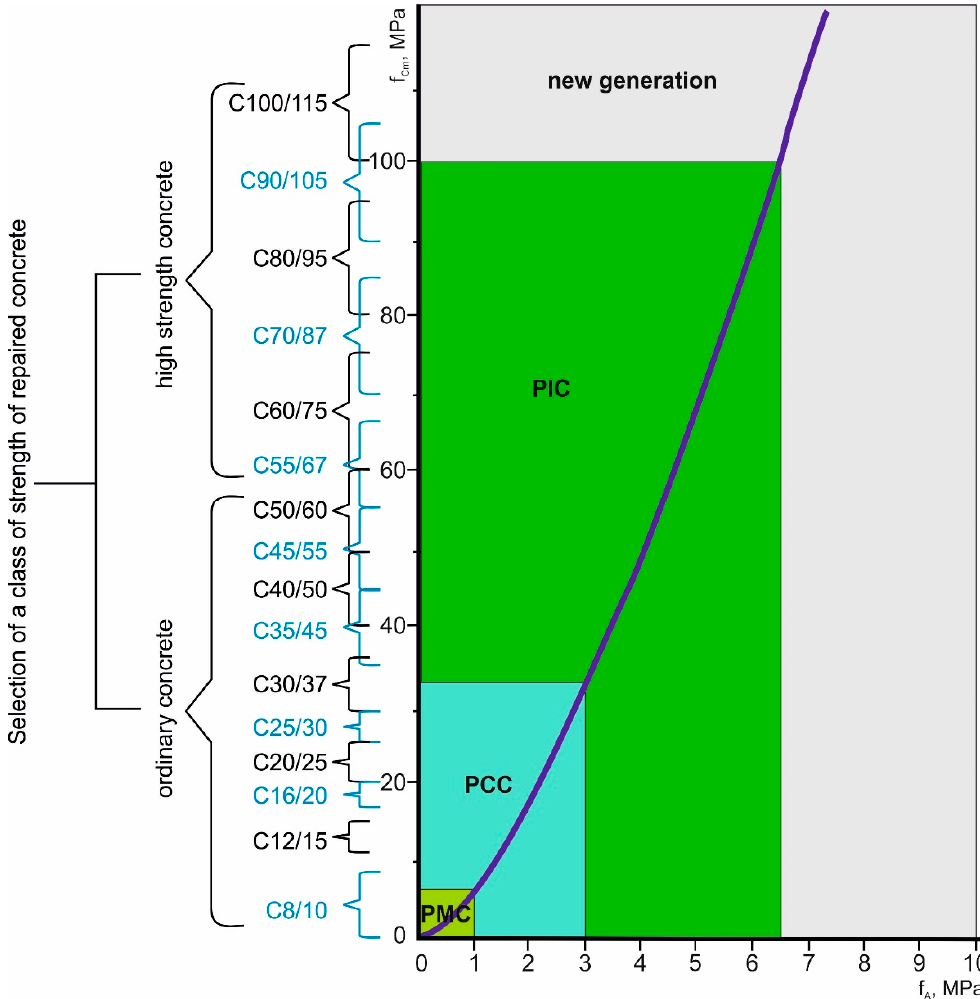
Figure 10. An algorithm of a selection of a polymer repair material depends on class of strength of repaired concrete substrate: PMC—Polymer Modified Concrete ( p ≤ 1%), PCC—Polymer Cement Concrete (1% < p ≤ 3%), PIC—Polymer Concrete ( p > 8%)—no Portland cement; p —polymer content, %—mass of concrete.